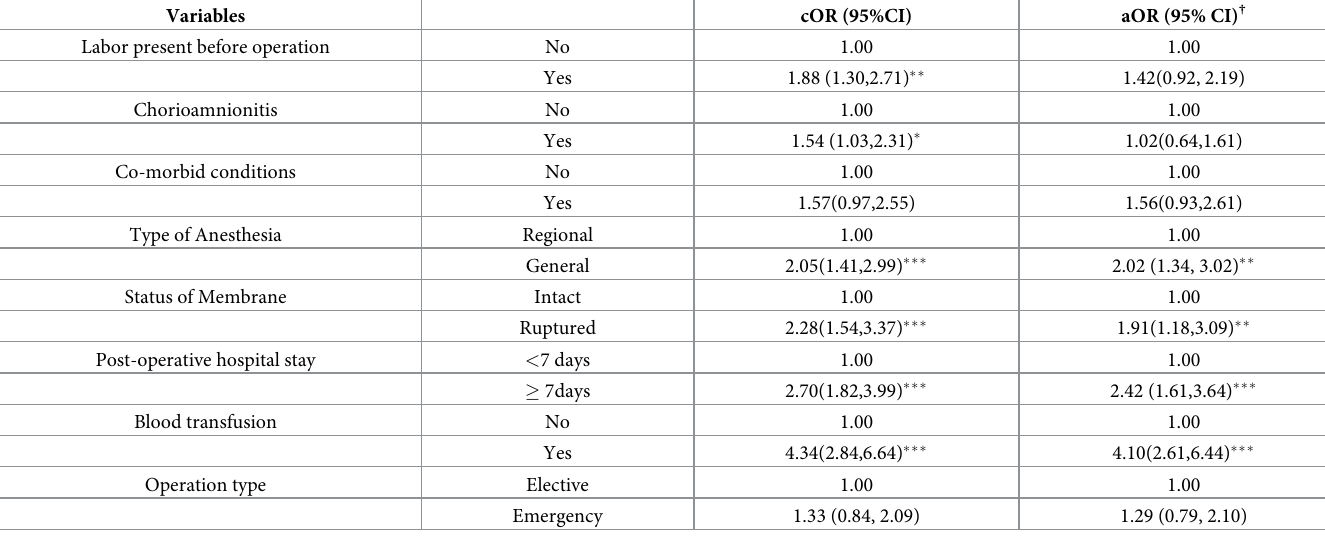
Table 4. Factors associated with post cesarean section surgical site infection in multivariable binary logistic regression